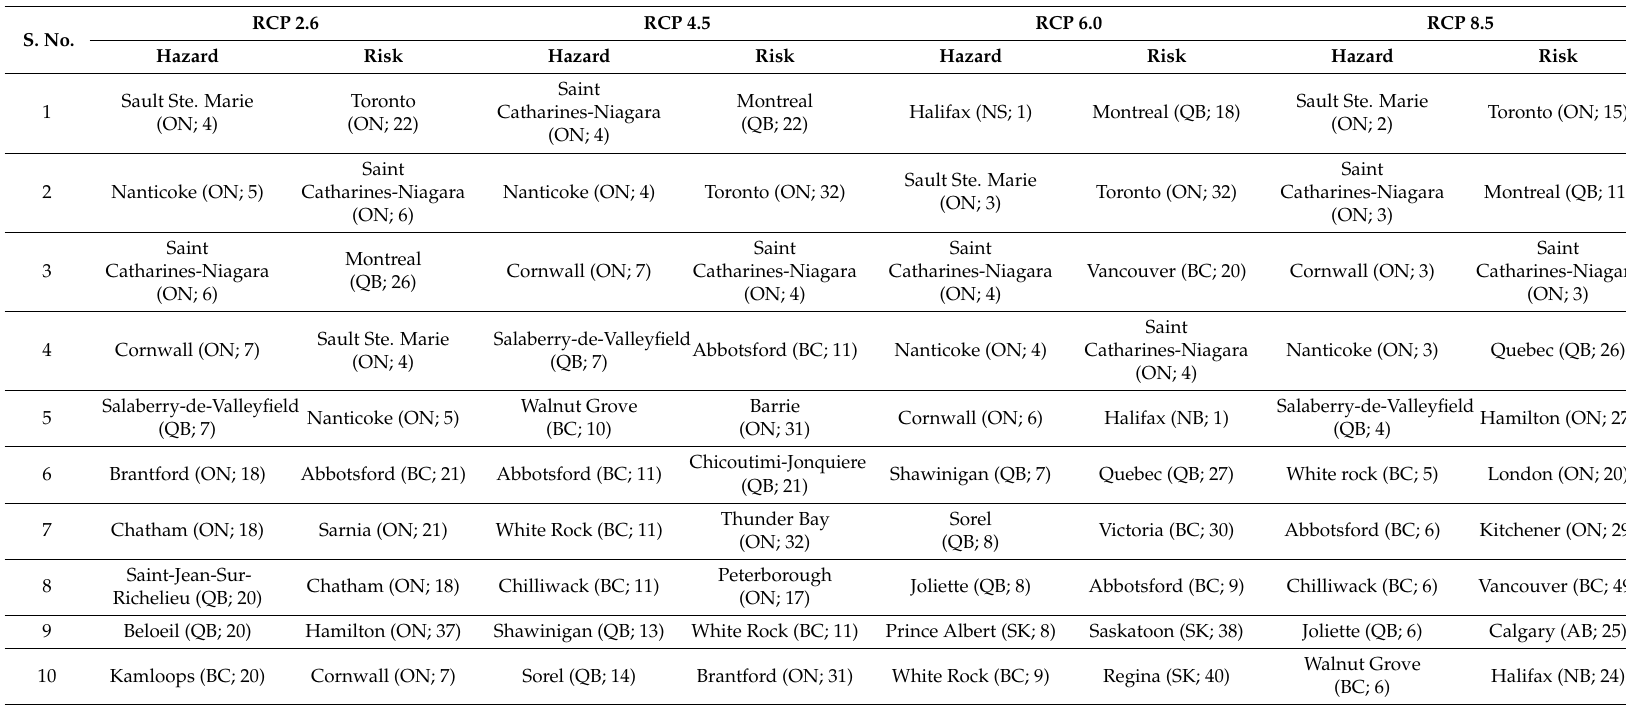
Table 4. Ten cities projected with most increases in historical 100-year return period flood-hazard and flood-risk following robust GCM median approach. Information on the province and projected future flood frequency of historical 100-year return period floods in years is also provided within brackets. S.